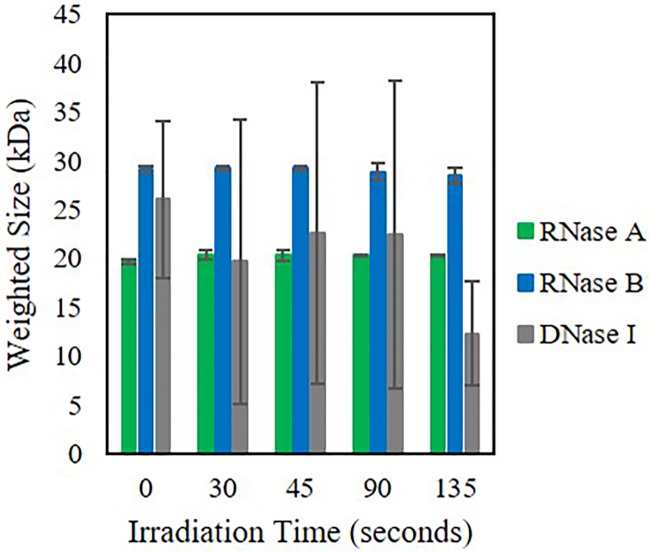
Weighted size (kDa) of RNase A, RNase B, and DNase I.Weighted size post microwave irradiation at 30% power, 60 seconds. In general, as irradiation time increases, the overall weighted nuclease size decreases and the error in the size becomes larger. This in indicative of an increasing number of varying size fragments with an overall degraded nuclease. Pre = No microwave irradiation.